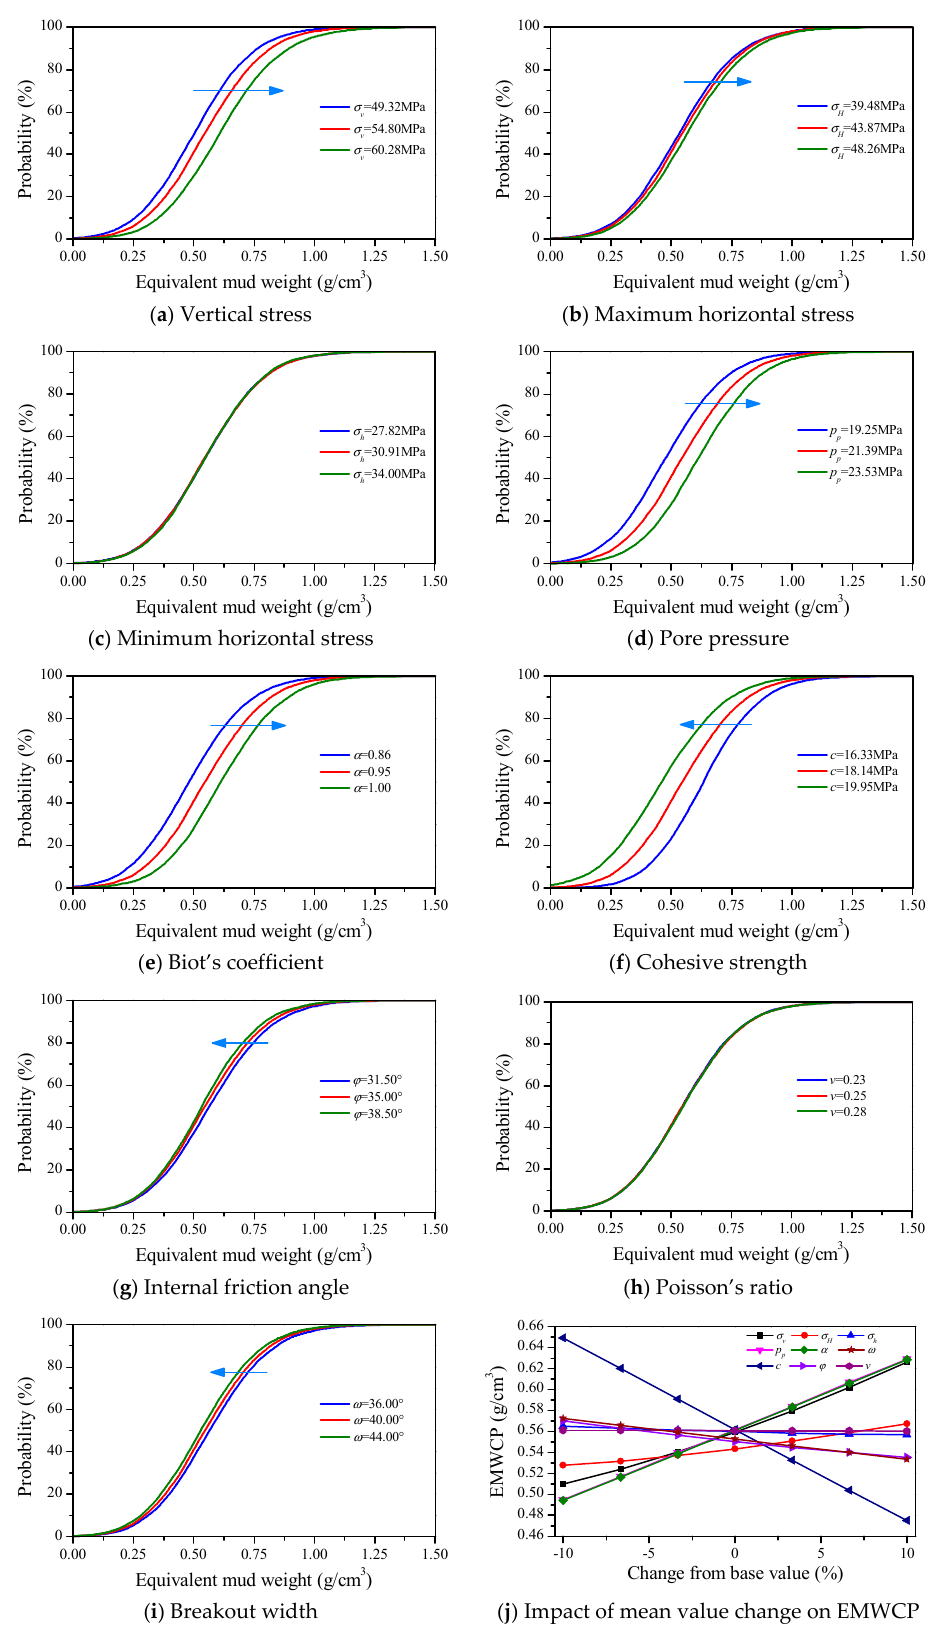
Figure 10. Influence of mean value on cumulative probability of EMWCP.